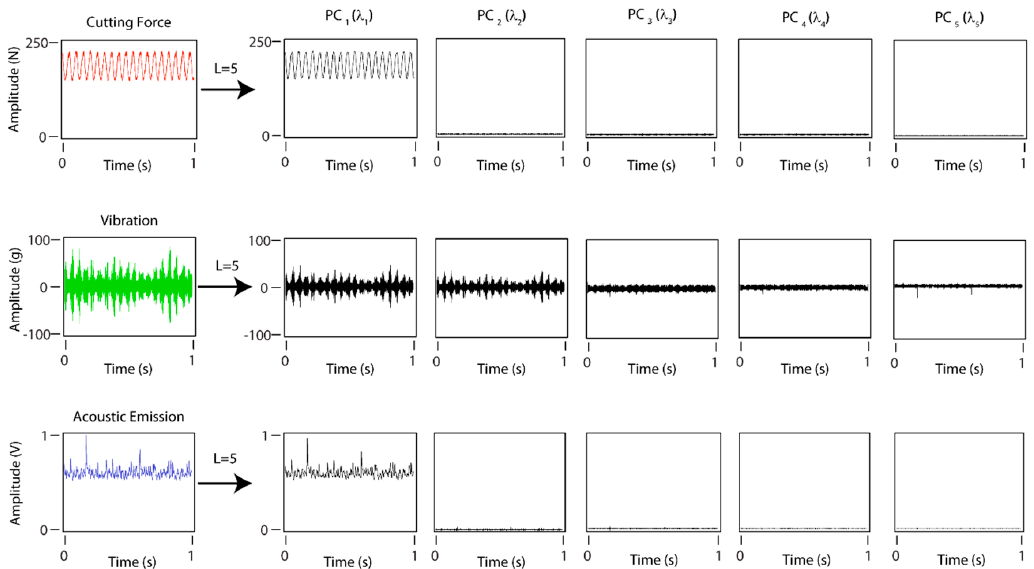
Figure 10. Principal components obtained with the WPT method for cutting forces, vibration, and acoustic emission, and a window length of L = 5.